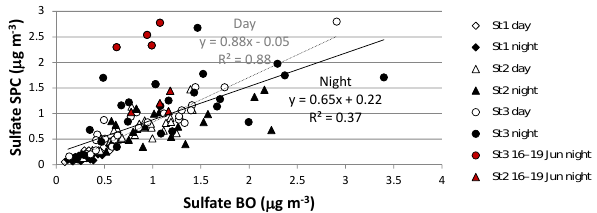
Figure 11. Scatterplot of sulfate concentration at SPC vs. BO dur- ing day and night for the impactor stages 1 (0.05–0.14µm), 2 (0.14– 0.42µm) and 3 (0.42–1.2µm). The regression lines are referred to the diurnal (gray line) and nocturnal (black line) concentrations in the three stages as a whole. Condensation- and droplet-mode sam- ples for the stagnant nights during 16–19 June are filled in